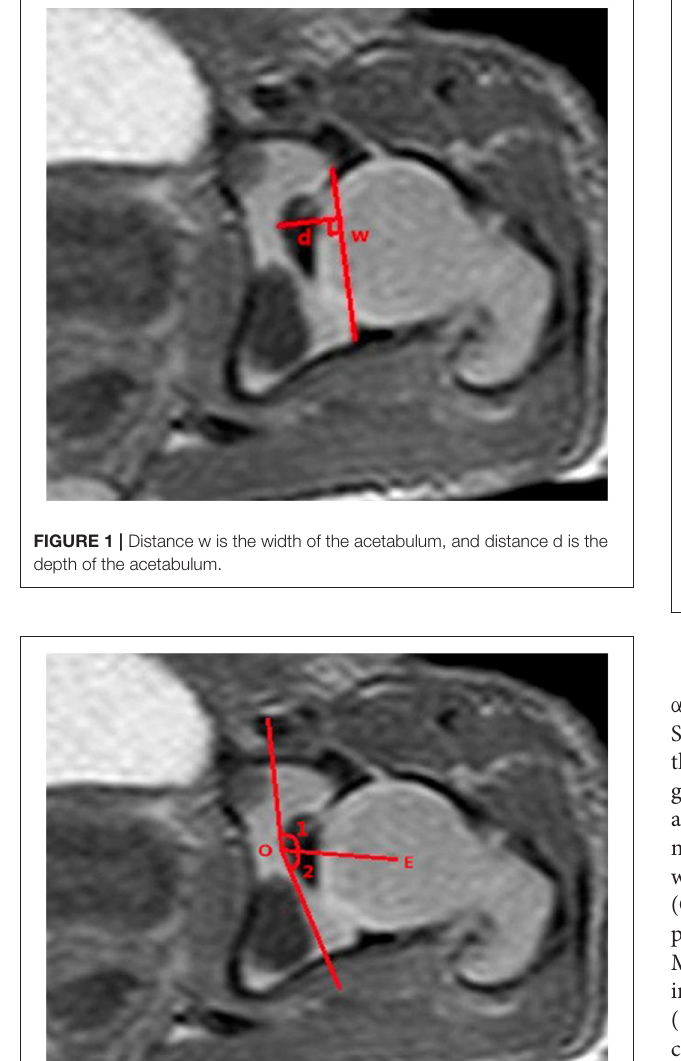
FIGURE 2 | Line OE is the baseline. Angle 1 is the ABAI, and angle 2 is the PBAI.